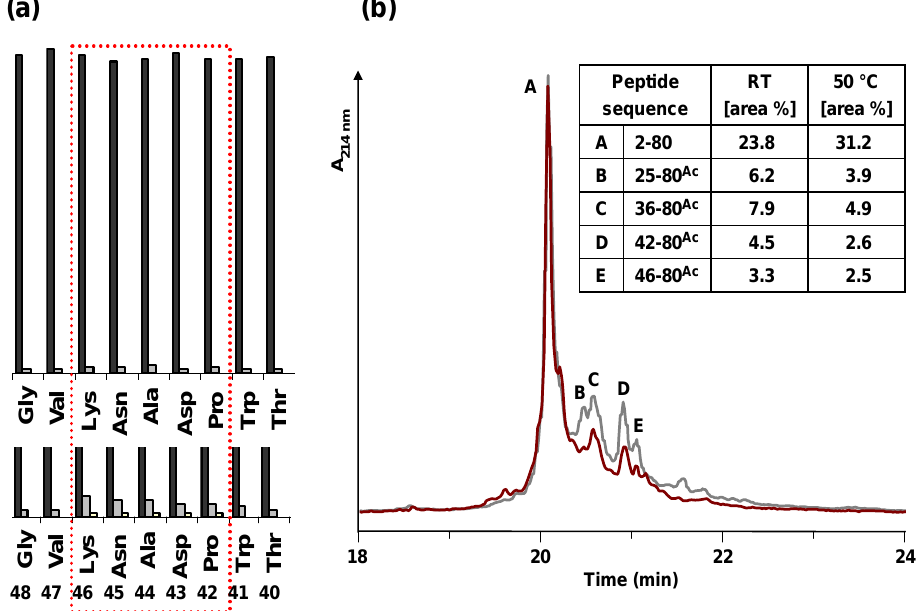
Figure 4. (a) Comparison of the UV measurement (Fmoc cleavage pattern) of the peptide synthesizer during the synthesis of HBVpreS/2-78 at room temperature (RT) and 50 °C. Compared to the synthesis at RT (lower part), during the synthesis at elevated temperature no third deprotection step in the region from aa 42 to aa 46 of the peptide sequence was required. (b) Analytical HPLC of the crude peptide after solid phase synthesis at elevated temperature. HPLC chromatogram of the product and major side product region (red line). The main peak corresponds to the desired product. In comparison to the synthesis at room temperature (grey line), the side products are decreased. Integration results (area %) of the two HPLC chromatograms are presented in the table. Conditions: Hypersil Gold C column; linear gradient of 0.1% TFA in water to 0.1% TFA in acetonitrile in 30 minutes, flow rate of 0.2 mL/min, 60 °C, wavelength of 214 nm.